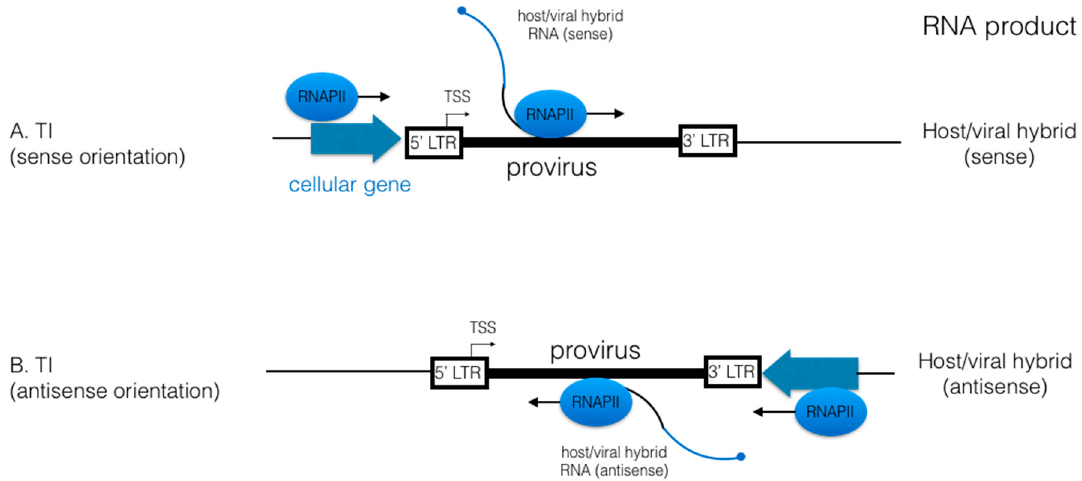
Figure 2. Host–viral hybrid RNAs are expressed by TI in latently infected cells. ( A ) When HIV integrates in the sense orientation within a host cell gene, the transcribing RNAPII reads through the boundary between the host gene and the 5’LTR or the HIV proviral DNA, and terminates in the 5 ′ - LTR (past TAR near the poly A site), resulting in the expression of host–viral hybrid (HVH) RNAs. ( B ) When HIV integrates in the antisense orientation within a host gene, RNAPII reads through without stopping and HVH RNAs containing HIV antisense RNA are produced.